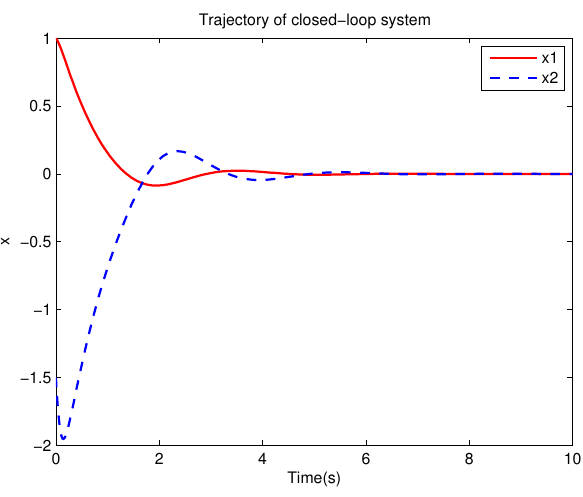
Figure 18. Closed loop system trajectory, p 1 = 2, p 2 =